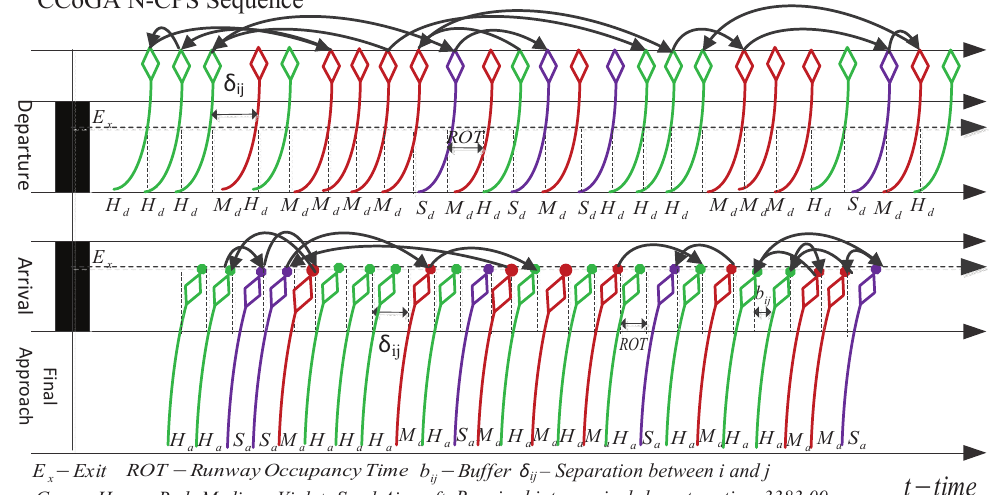
Figure 11. Time-space diagram of the CCoGA N-CPS sequence: a flight can shift its position either any position left or any position right from the FCFS